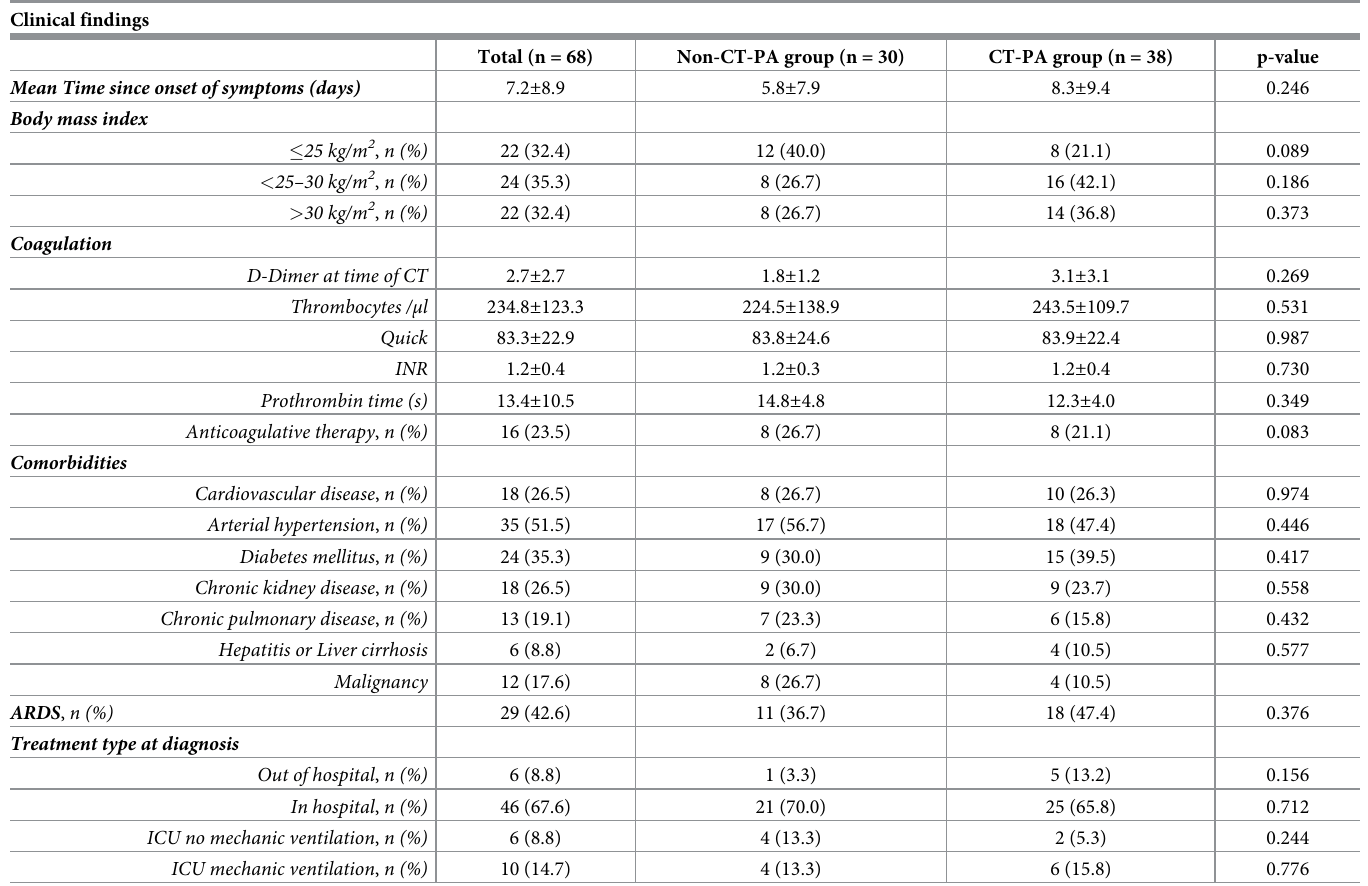
Table 3. Clinical findings in COVID-19-cohort. Computed tomography pulmonary angiography (CT-PA), Number of patients (n), Acute respiratory distress syndrome (ARDS), Intensive care unit (ICU), International normalized ratio (INR). Clinical